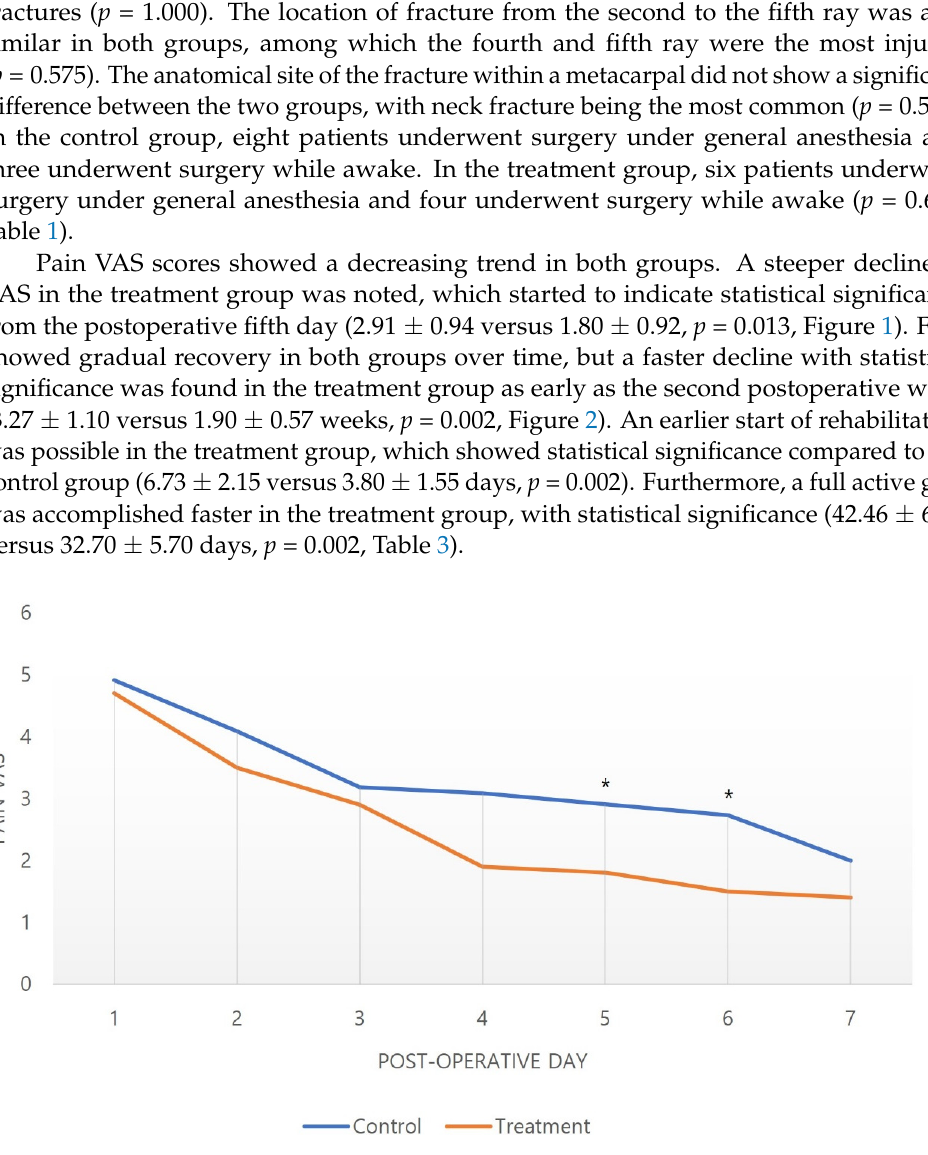
Figure 1. The pain VAS was observed to decrease with time in both groups. However, it was found that there were significant differences on the fifth and sixth day, which means that the pain decreased more rapidly in the treatment group. * p -Value ≤ 0.05.